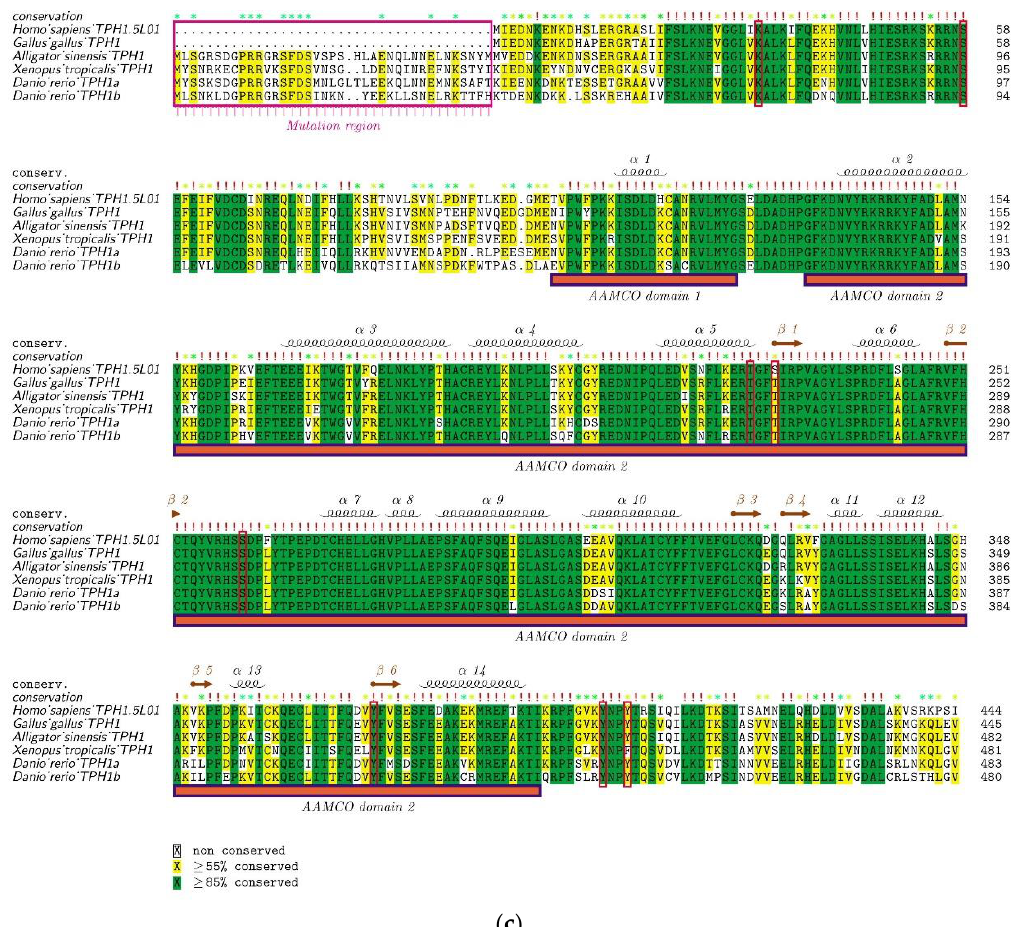
Figure 4. Alignment and secondary structures of TPH protein sequences in vertebrates. ( a ) TPH2 protein sequences from representative vertebrate species were aligned with the human TPH2 and its secondary structure template 4V06. ( b ) Sequence alignment between TPH1a and TPH1b in some representative teleosts is provided for comparison. ( c ) TPH1 protein sequences from representative vertebrates were aligned with the human TPH1 and its secondary structure template 5L01. The mutation regions are marked with rose boxes and upper arrows in each figure. The red boxes denote the phosphorylation sites based on the human templates. Related alignment and secondary structures in more vertebrate species are provided in Figure S2.